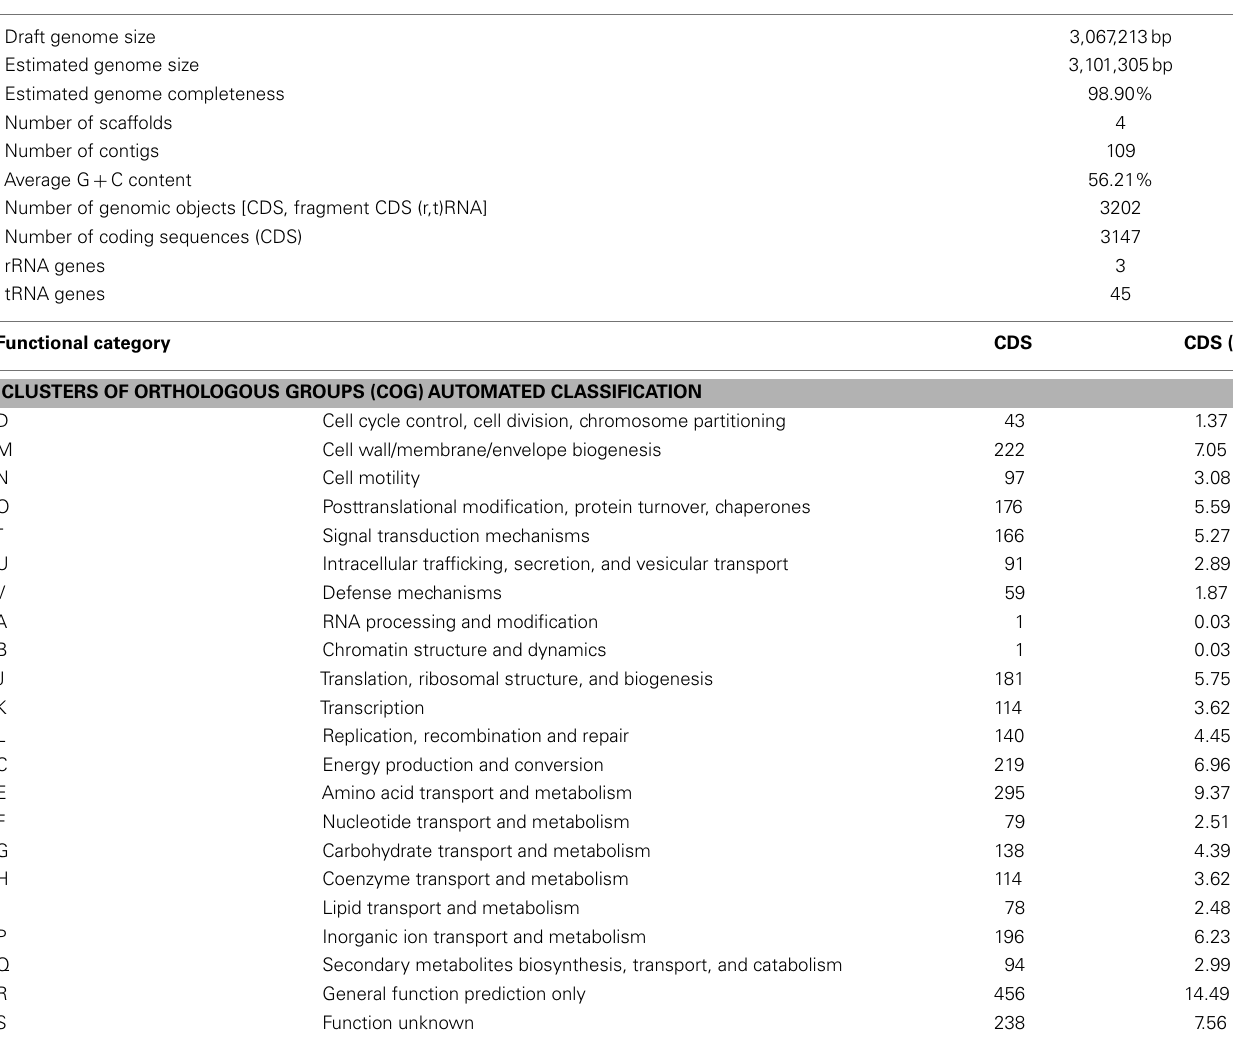
Table 1 | Overview of key features of the Nitrospina gracilis strain 3/211